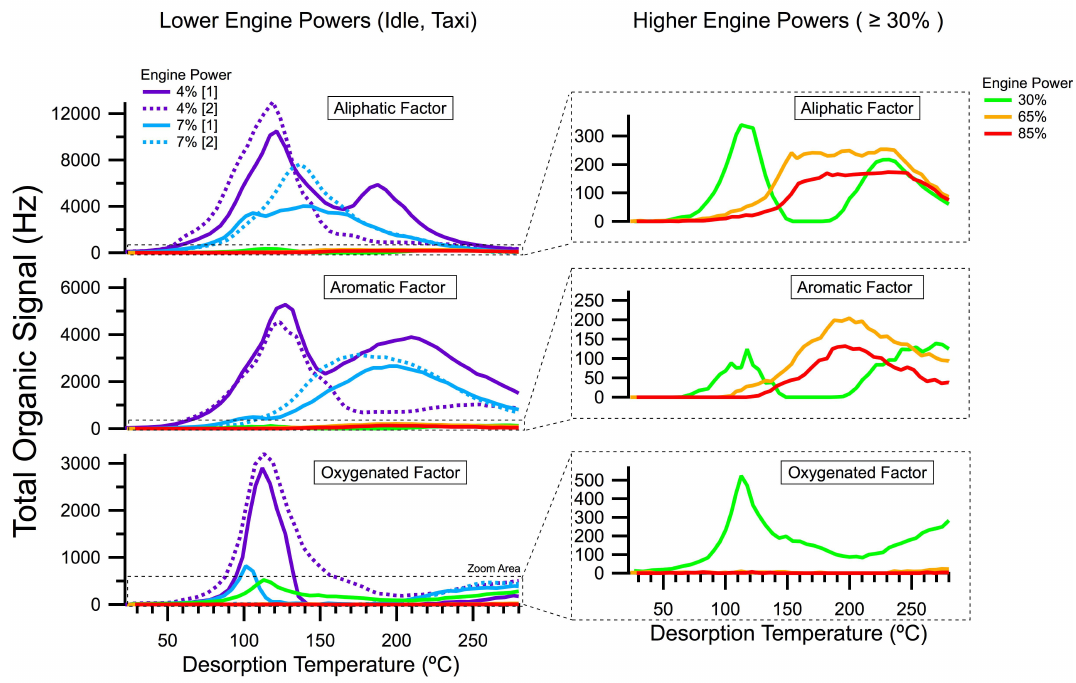
Fig. 8a. Desorption profiles for aliphatic, aromatic, and oxygenated PMF factors. Results obtained from higher engine powers ( ≥ 30%) are re-scaled on the right-hand side of the graph for clarity.